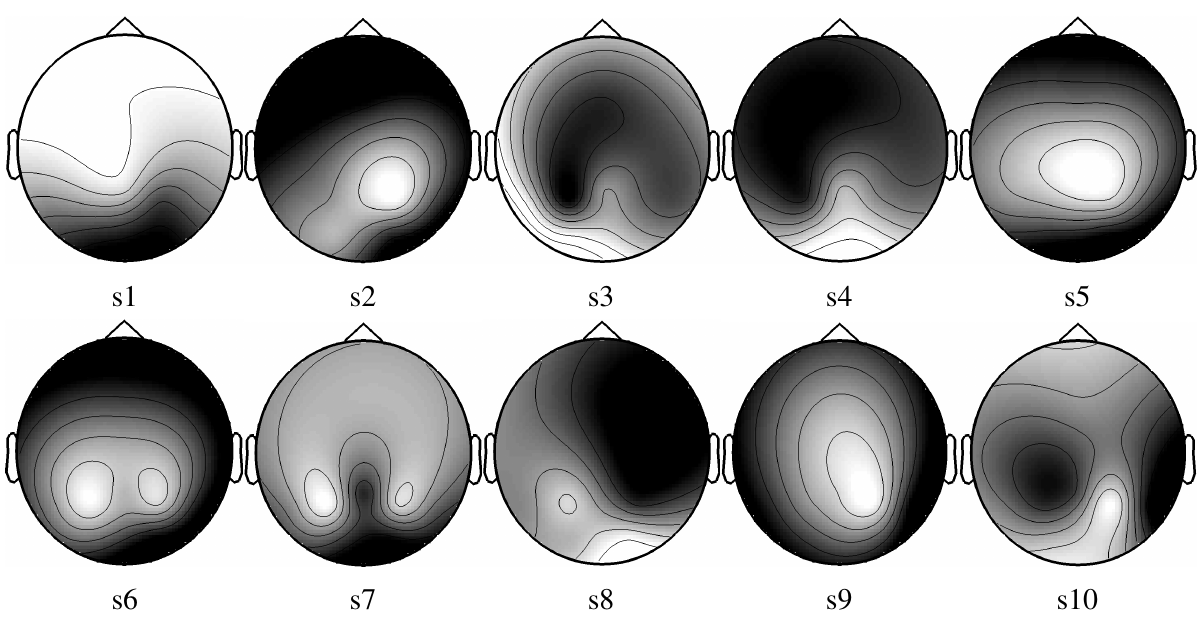
Figure 6. Electrode scores after electrode selection based on the maximization of the SSNR for each subject ( SS ). (A low gray level represents a high score for the individual